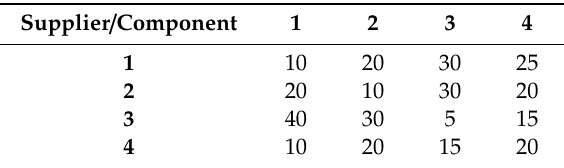
Table 18. Undiscounted unit prices ( P ij ).